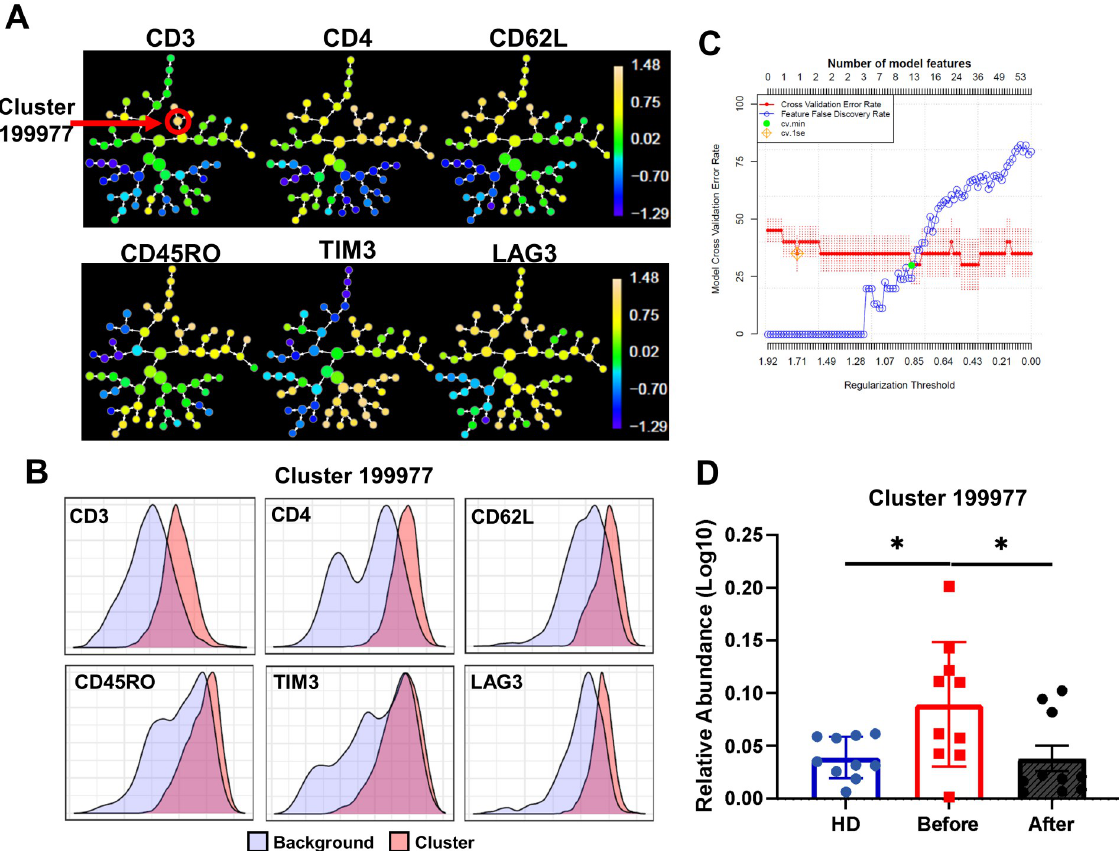
Fig 5. CITRUS analysis of T cell samples obtained from healthy donors (HDs), before, and after chemotherapy. A . Cluster distribution (hierarchy) and expression level of the corresponding marker from low (blue) to high expression (pink) for each marker, arrow points at cluster 199977. B . Histograms depicting the phenotype of cluster 199977 (red histograms) relative to background expression (blue histograms) for each marker (CD3, CD4, CD62L, CD45RO, TIM3, and LAG3. C . Cross validation error curves for number of models predicted by CITRUS, red curve: Cross Validation Error Rate, Blue Curve: Feature False Discovery Rate. Symbols represent best models CV. Min and CV 1SE. D . Relative abundance (Log10) of cluster 199977 in the three groups, HD (blue bars), patients before chemotherapy (red bars), and after chemotherapy (gray bars) (n = 10/group). A nonparametric t -test was performed with unpaired Mann-Whitney test data to compare HD and BC patient’s. Data presented as means ± SEM ( � p <